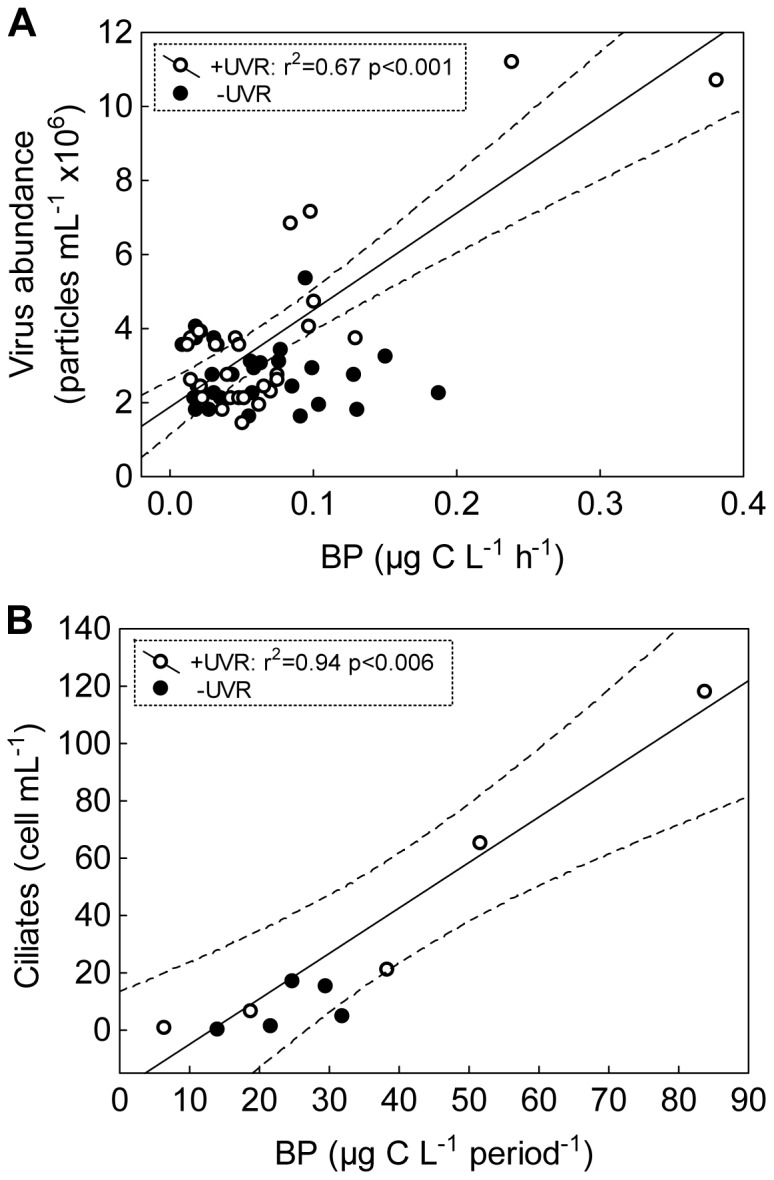
Linear regressions between structural and functional variables.(A) Virus abundance vs. BP; (B) ciliate abundance vs. total BP estimated for the PA period. Dashed lines indicate 95% interval confidence for each regression. (PA period: phosphorus-availability period).